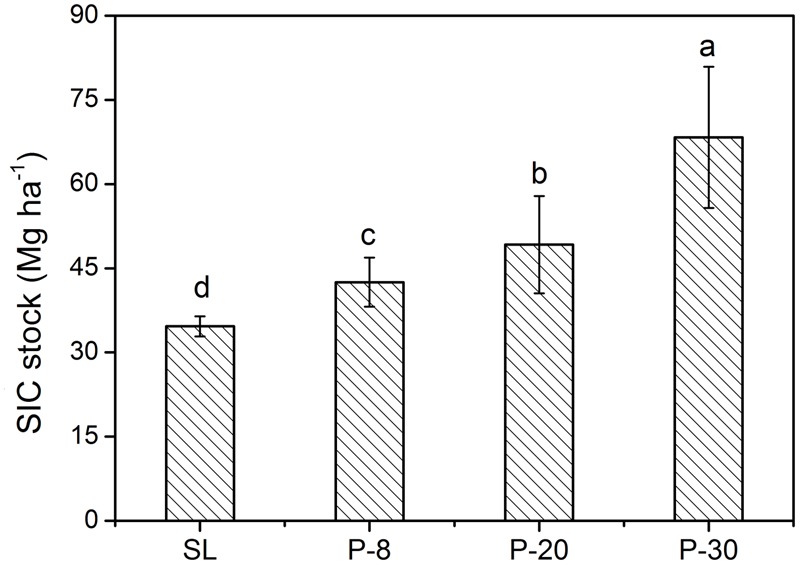
Soil inorganic carbon (SIC) stocks within 0–100 cm in shifting sand land (SL), 8-year-old poplar (P-8) land, 20-year-old poplar (P-20) land, and 30-year-old poplar (P-30) land (mean ± SD; n = 13). Different lowercase letters denote significant differences among the treatments (P < 0.05).